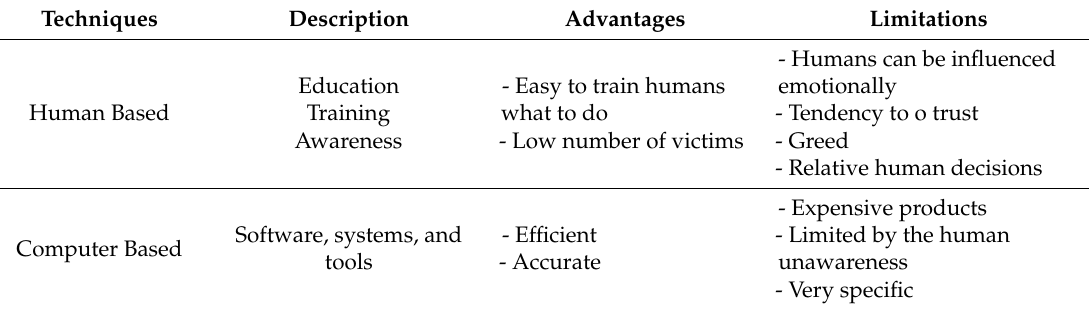
Table 1. Human-based versus computer-based countermeasures